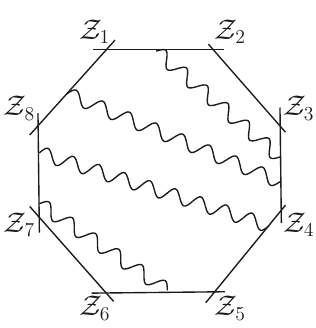
Figure 3 . Example of a Wilson loop diagram which contributes to the 8-point N 4 MHV amplitude. dimensional analogue of the second way of tessellating polygons, introducing an additional vertex Z and triangulating to that, (cid:12)gure (cid:3)